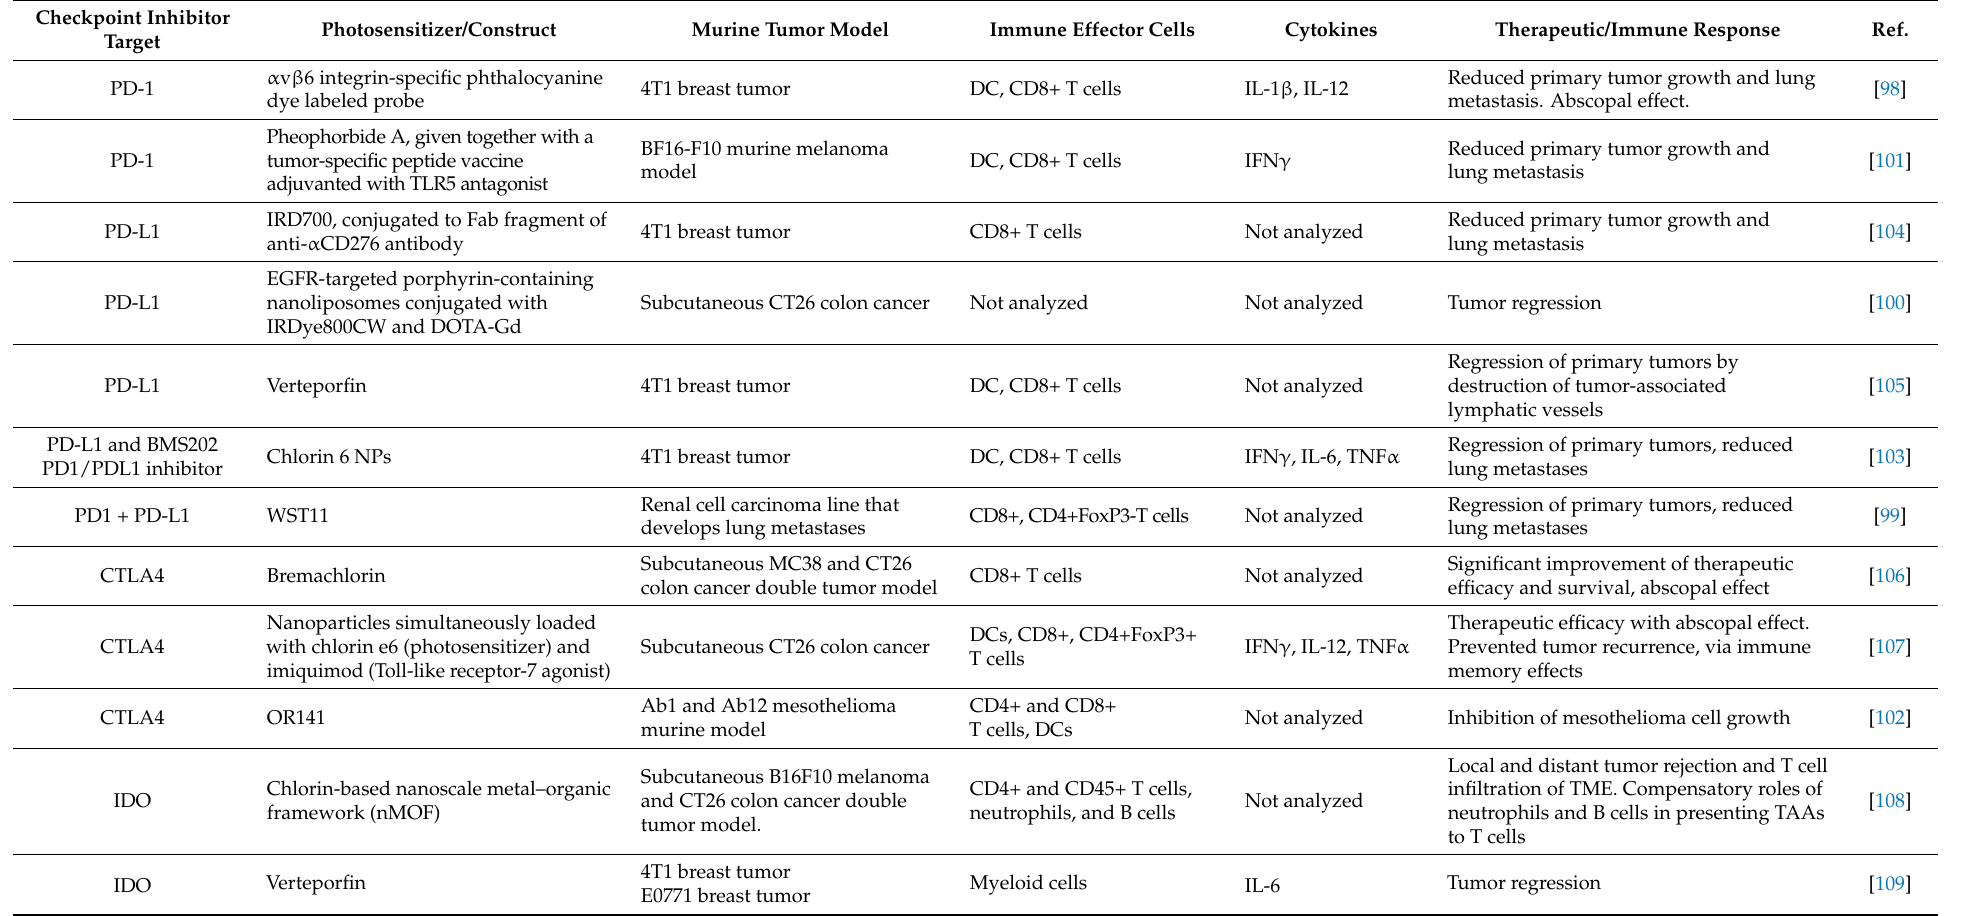
Table 1. A list of selected pre-clinical studies using combinations of immune checkpoint inhibition and photodynamic